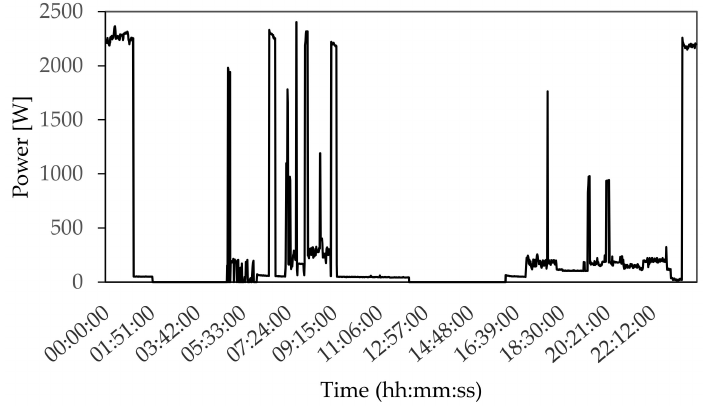
Figure 9. Example of electricity demand depending on time (house with 4 inhabitants).